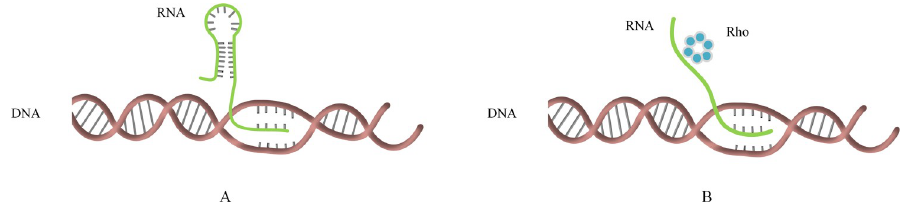
Fig 1. Transcriptional termination process. (A) The termination doesn’t require Rho. The transcription stops when the RNA forms the stem loop structure. (B) The termination dependents on